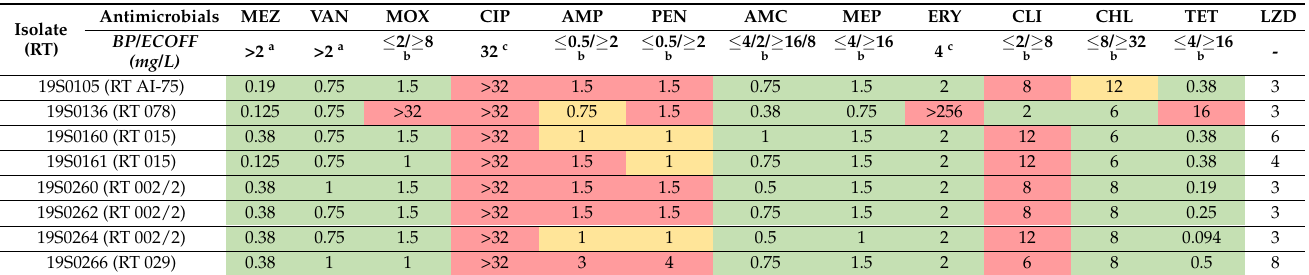
Table 5. Results of antimicrobial susceptibility testing (minimum inhibitory concentration, in mg/L) for C. difficile isolates from